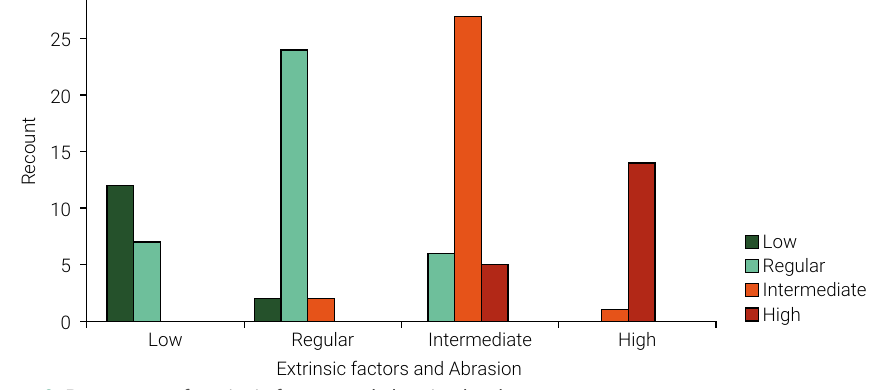
Figure 3. Percentage of extrinsic factors and abrasion